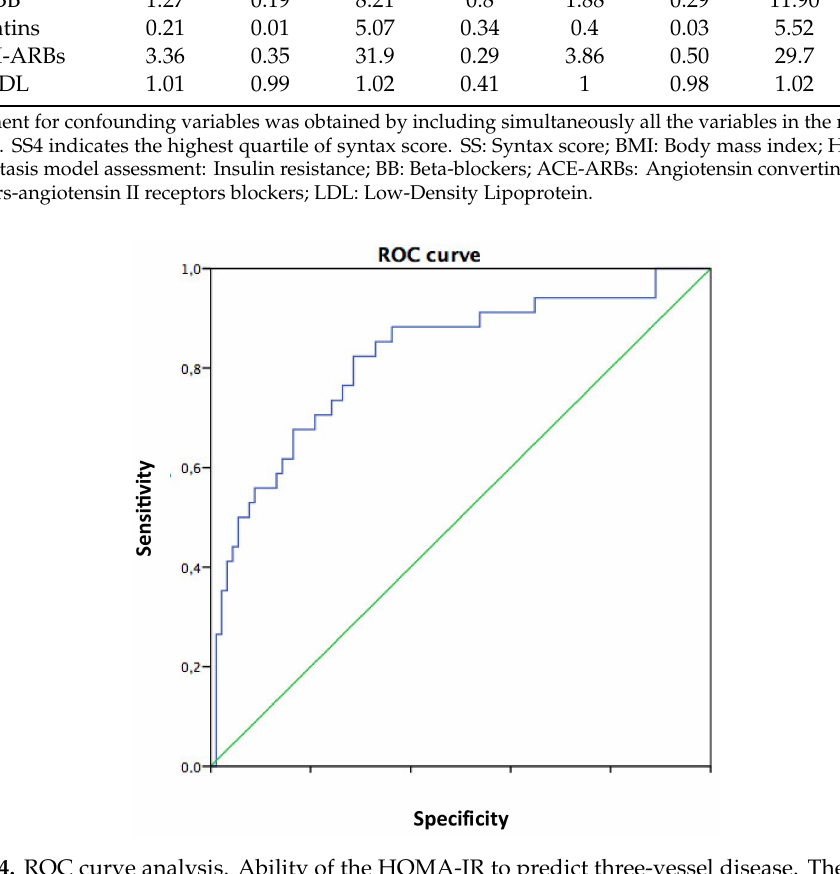
Figure 4. ROC curve analysis. Ability of the HOMA-IR to predict three-vessel disease. The AUC is 0.82. The area under the curve (AUC) is 0.82. The HOMA-IR has a good accuracy in predicting patients with or without three-vessel